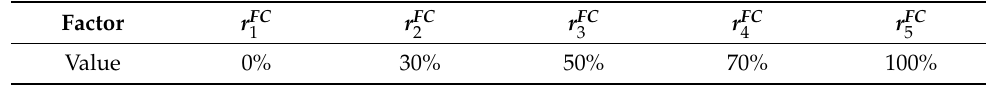
Table 1. Different FC power contribution factors.